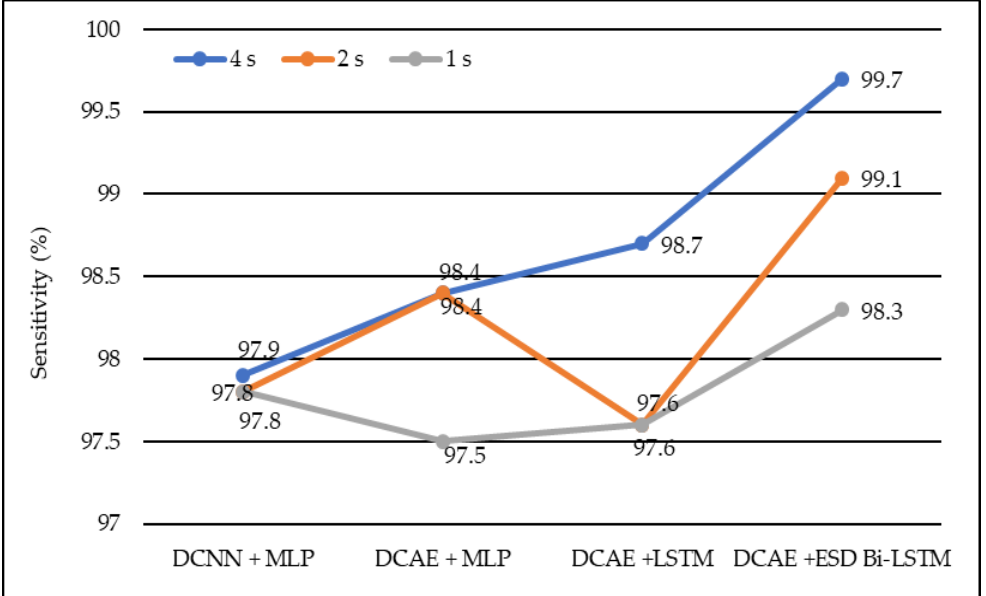
Figure 4. The average accuracy of different models using different EEG segment lengths.